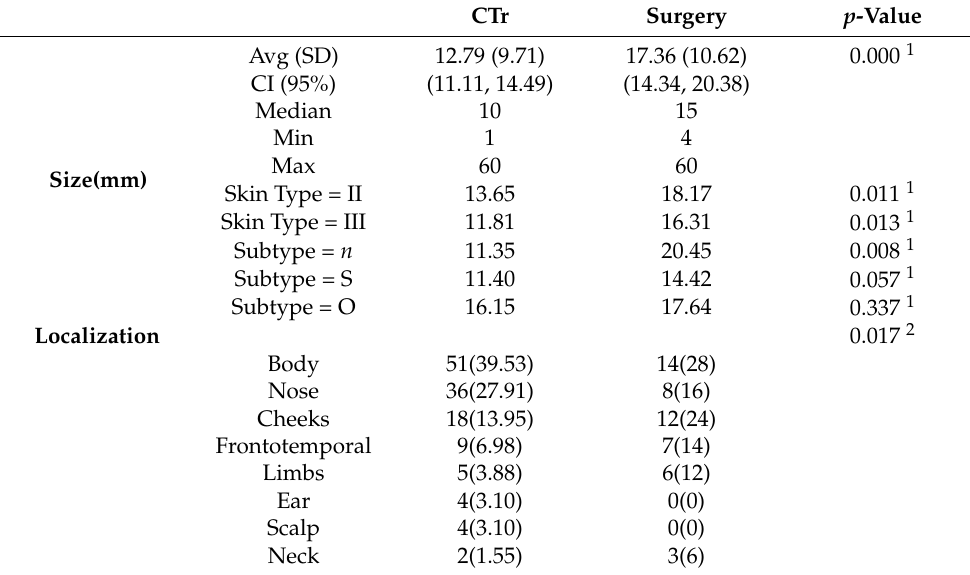
Table 2. Size variation and localizations in the two subgroups.